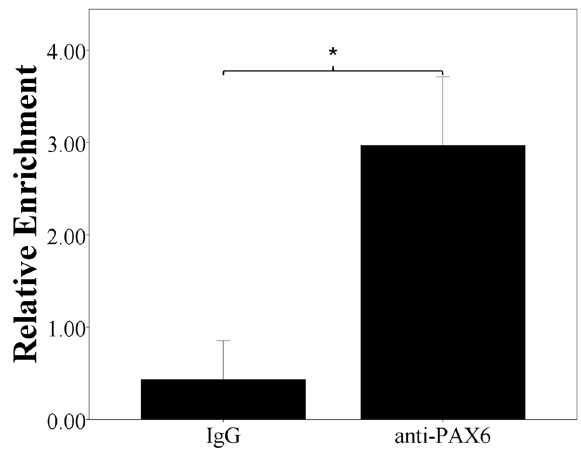
Figure 4 – Enrichment of the chromatin spanning rs72755295 in MCF-7 cell line. The y axis represents relative enrichment. The result is normalized by input and the data is expressed as mean±SD. * indicates P